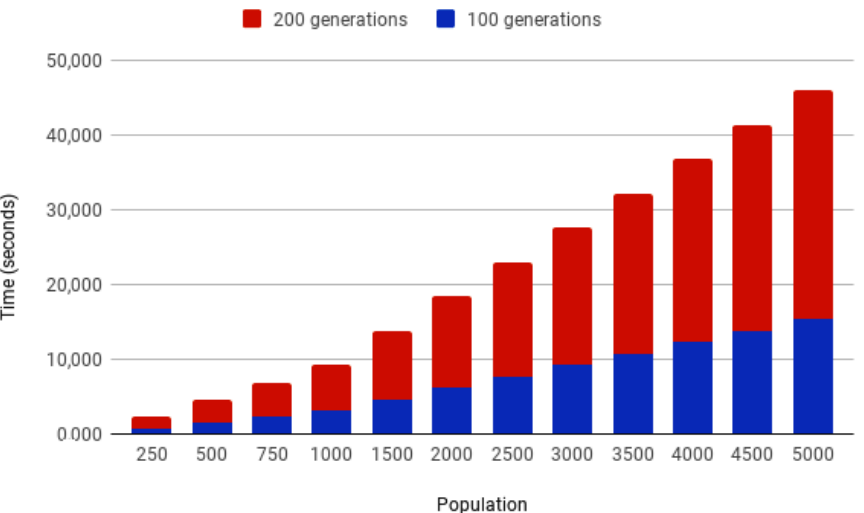
Figure 8. Computation time of different executions of the genetic